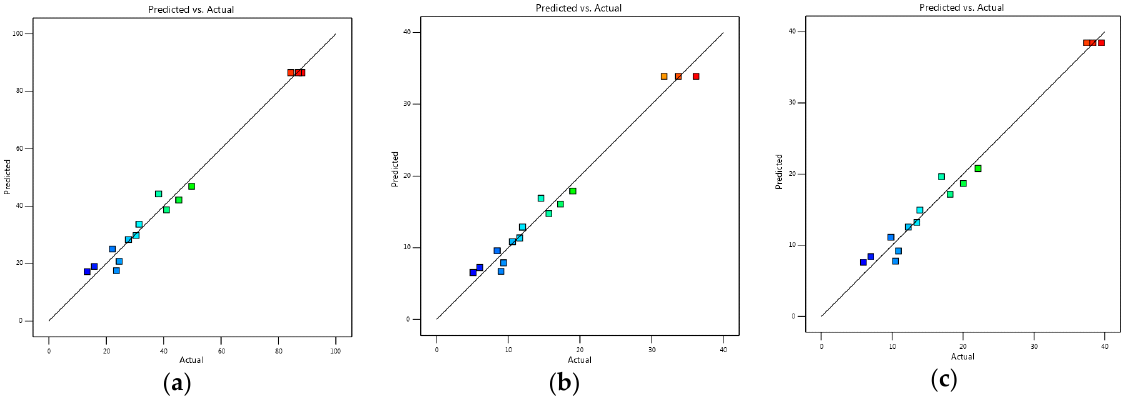
Figure 2. The correlation between predicted target function and actual target function: ( a ) Y 1 , ( b ) Y 2 , ( c ) Y 3 , respectively.